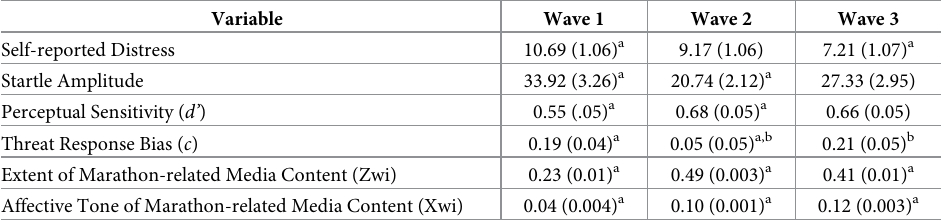
Table 1. Estimated means and standard errors by